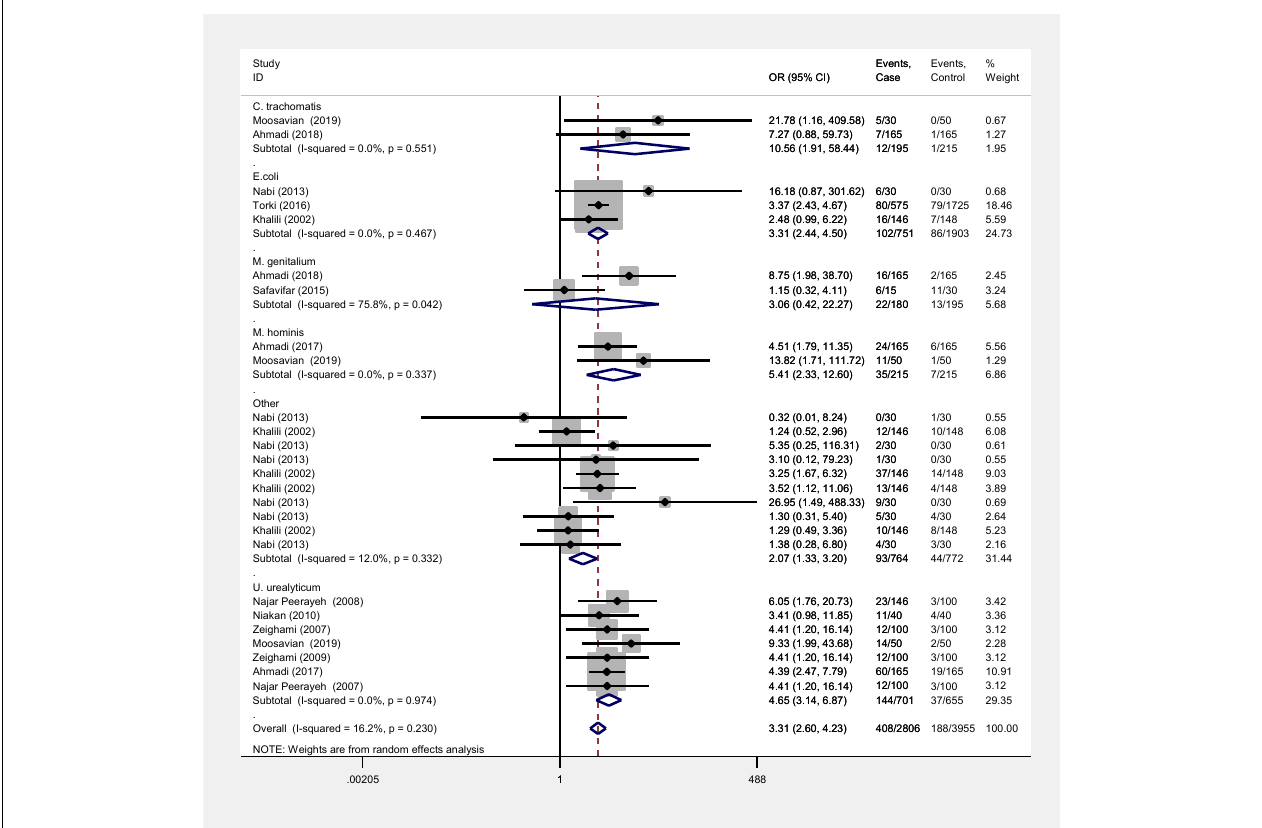
FIGURE 6 | Estimation of odds ratio of male infertility due to exposure to different bacteria.